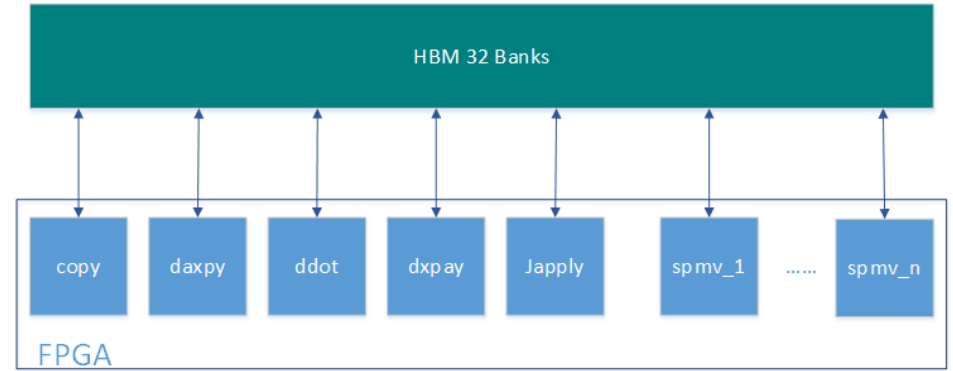
Figure 1. FPGA implementation of PCG on Alveo